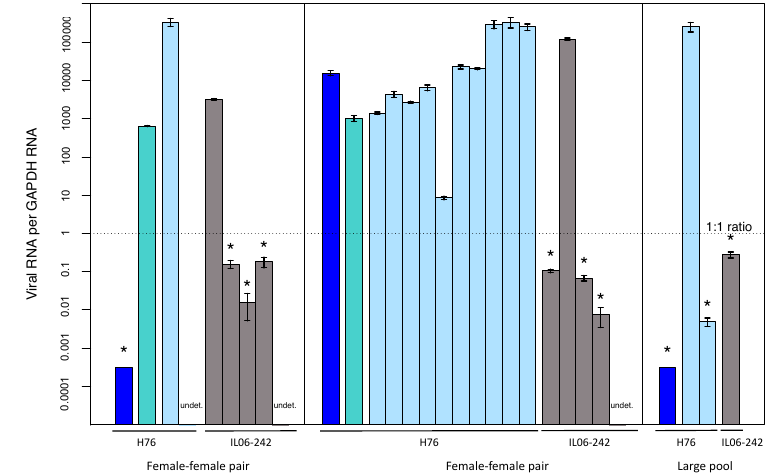
Figure 8. Transmission assay results: pools with observed horizontal transmission tested with qPCR. Bars represent the relative viral load per GAPDH ± standard error of an individual wasp and are shown on a log scale. Nine asexual individuals were newly infected across the three pools. Samples negative for PCR but positive for qPCR are labelled with asterisks and the dashed line displays where viral and GAPDH transcription are equal. Generations and lines are labelled by colors as follows: H76 generation 1 (blue), H76 generation 2 (turquoise), H76 generation 3 (light blue) and IL06–242 generation 3 (gray). Only H76 individuals are shown for generations 1 and 2, as all asexual individuals were negative for the virus in these generations. All emerged individuals, positive or negative for the virus, are shown for both lines in generation 3. No generation 2 individuals are shown for the large pool as wasps were not removed and hence not tested for this